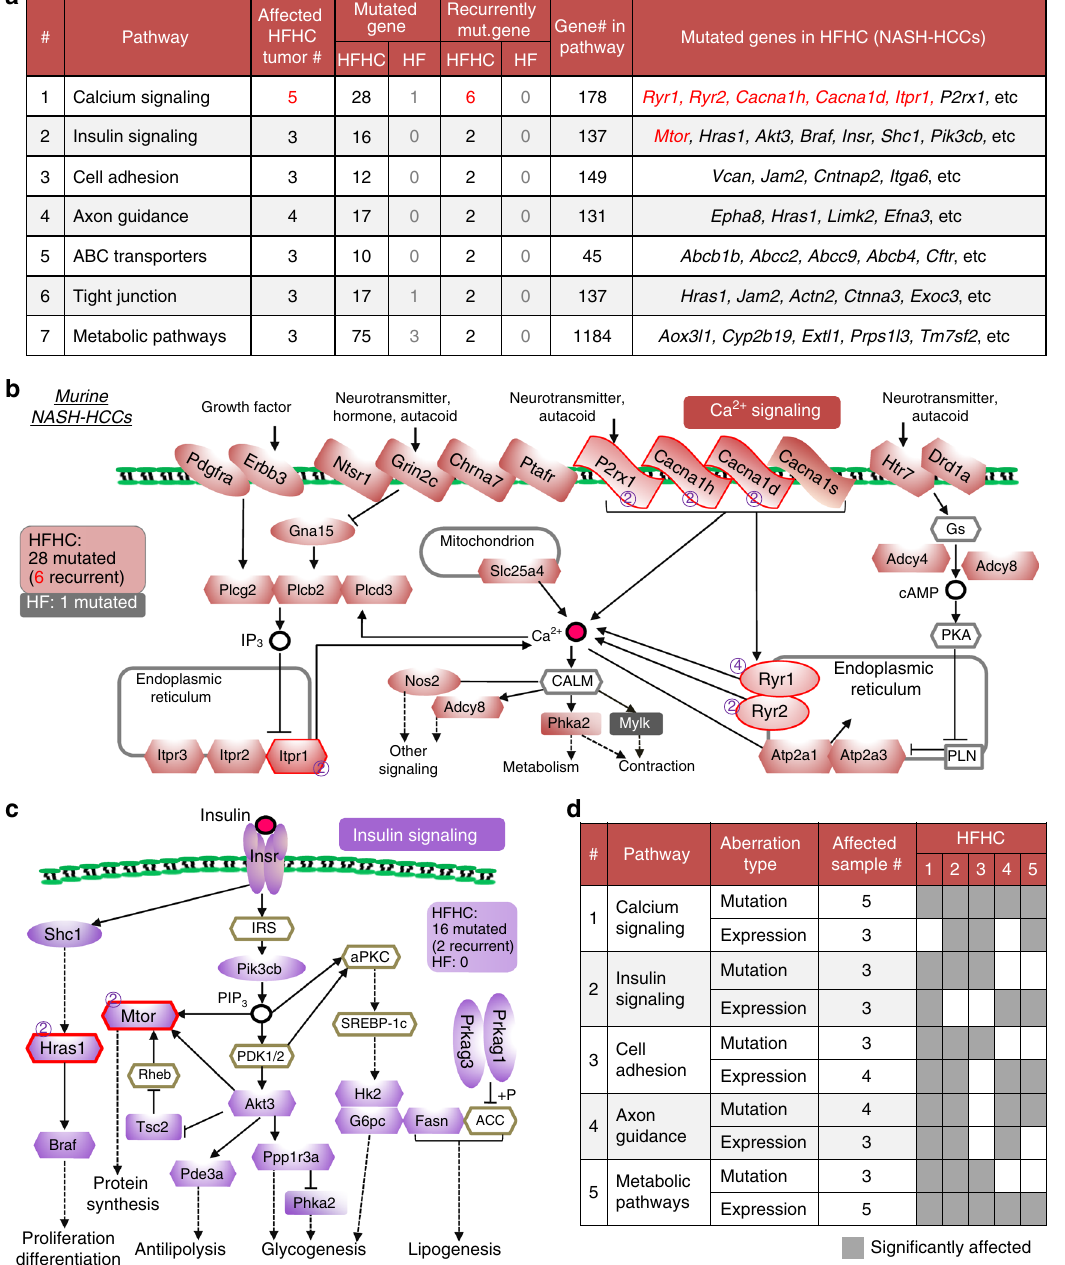
Fig. 6 Pathways dysregulated by genetic alterations. a Seven pathways were signi fi cantly dysregulated in three or more NASH-HCCs from HFHC-fed mice ( ≥ 3 genes involved in each sample, adjusted P < 0.05). b Mutated genes in calcium signaling pathway are indicated. 28 genes were mutated in NASH- HCCs, 6 of which were recurrently mutated. Only one gene in calcium signaling pathway was mutated in one of the steatosis-HCCs. Color- fi lled icons show mutated genes. Recurrently mutated genes were highlighted with affected NASH-HCC numbers denoted. c Mutated genes in insulin signaling are indicated. 16 gene were mutated in NASH-HCCs, 2 of which were recurrently mutated, while no gene was mutated in steatosis-HCCs. d Five pathways were enriched commonly by mutations and aberrant gene expression in genes in NASH compared to steatosis, including Ctnnb1 and Myc (Fig. 2). As similar upregulated expression of Wnt signaling genes has been reported in HCC, our fi nding supports the hypothesis that NASH is more prone to malignant transformation than steatosis through inducing in fl ammatory pathways, including those pertinent to Wnt signaling.